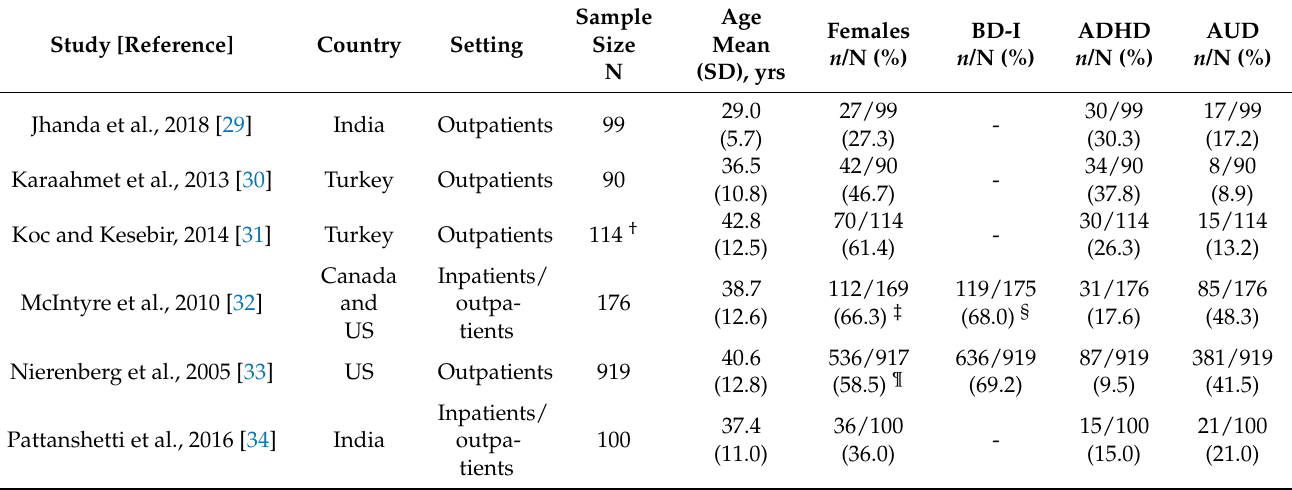
Table 1. Characteristics of studies included in the